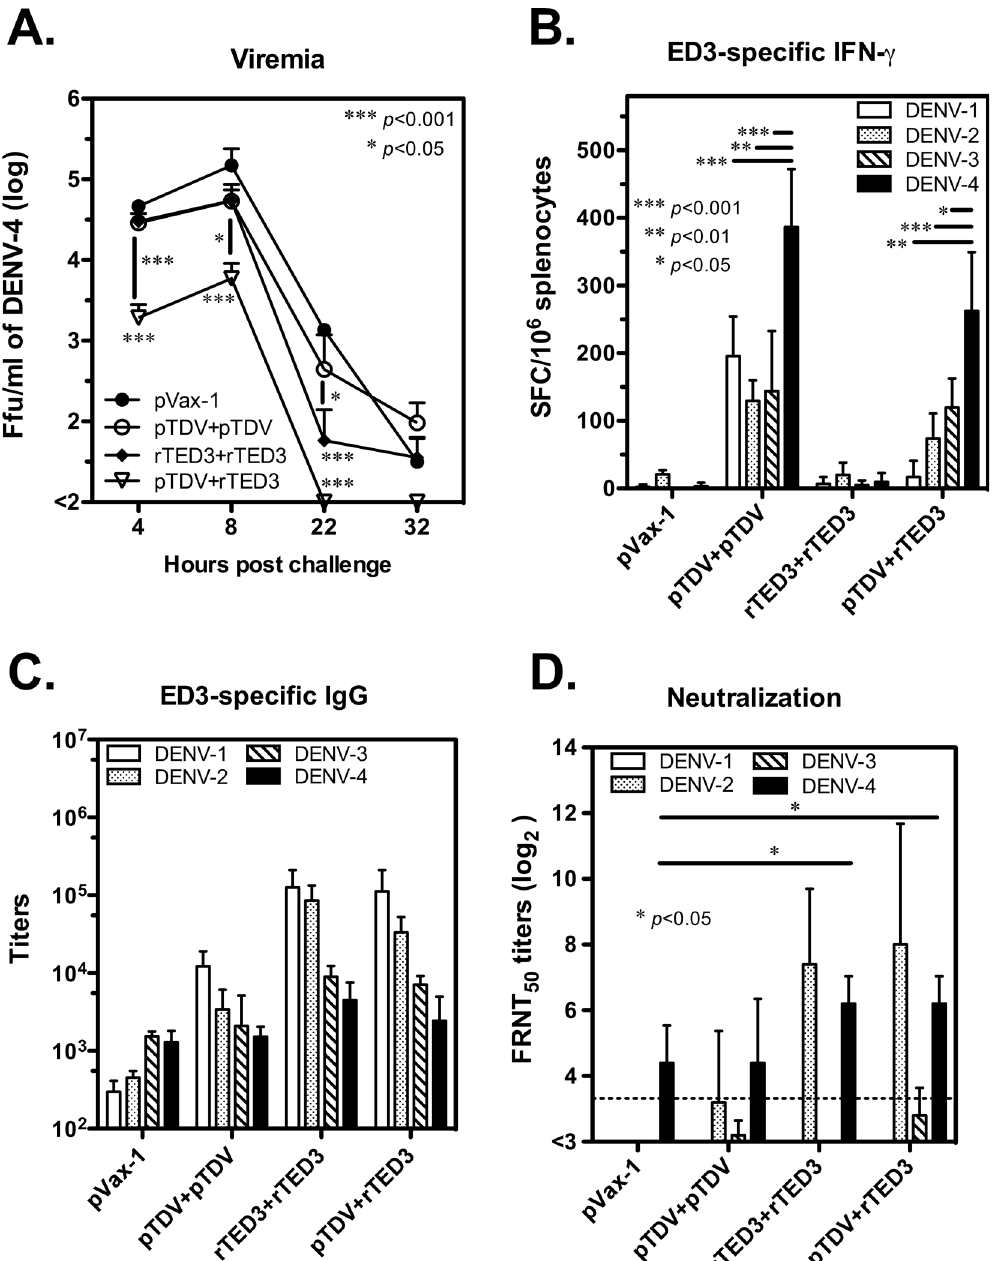
Fig 6. Protection, IFN- γ responses and antibody titers in tetravalent dengue vaccine-immunized mice after DENV-4 challenge. Groups of 6- to 8-week-old BALB/c female mice (n = 6, except n = 4 for pVax-1) were immunized three times at 2-week intervals with pVax-1, pTDV-ED3, rTED3 or prime- boost as the same schedule in Fig 2. Four weeks after the last immunization, mice were challenged with the intraperitoneal injection of 5 x 10 7 DENV-4 infected K562 cells. (A) Plasma viremia titers from individual mice were determined by viremia assay and are represented as the mean and SD. The significance shown in the graph was determined in comparison to the pVax-1 group, if nothing else is indicated. (B) Spleen cells were harvested for the detection of the ED3-specific IFN- γ production by ELISPOT at 1 month post-challenge. (C and D) The sera collected at 1 month post-challenge were used for the detection of neutralizing titers in an FRNT assay (C) or ED3-specific IgG titers by ELISA